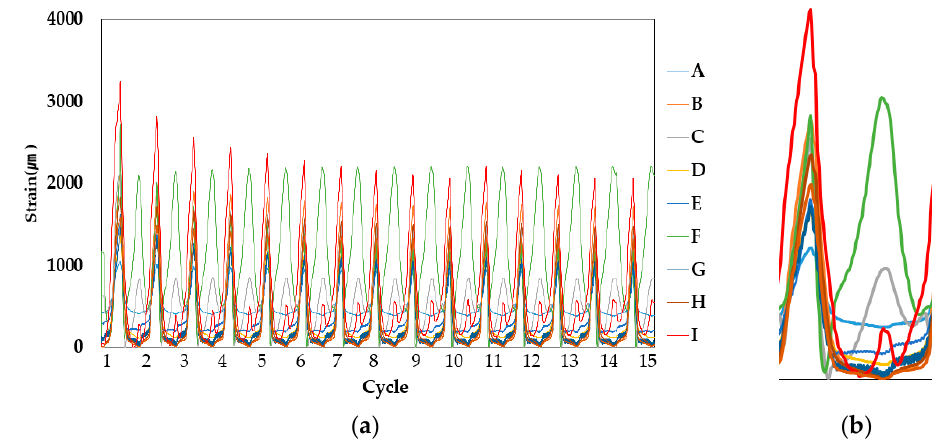
Figure 8. SAS (Specimen 1, 1.5 mm specimen sample) strain measurement result: ( a ) overall result and ( b ) single peak result of upper and lower section strain, magnified.